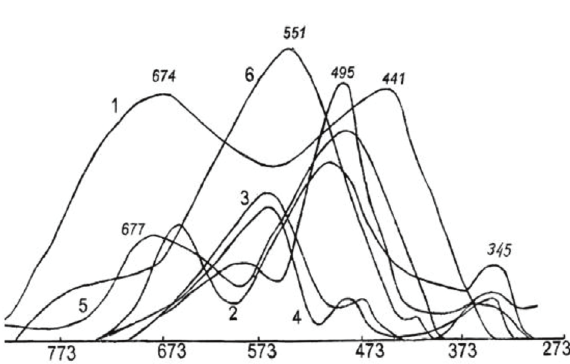
Fig. 8 – Thermal desorption of the catalysts with different compositions in condition of linear programmed increase in temperature of the catalysts from 293 to 1023 K; 1–5 % Rh/